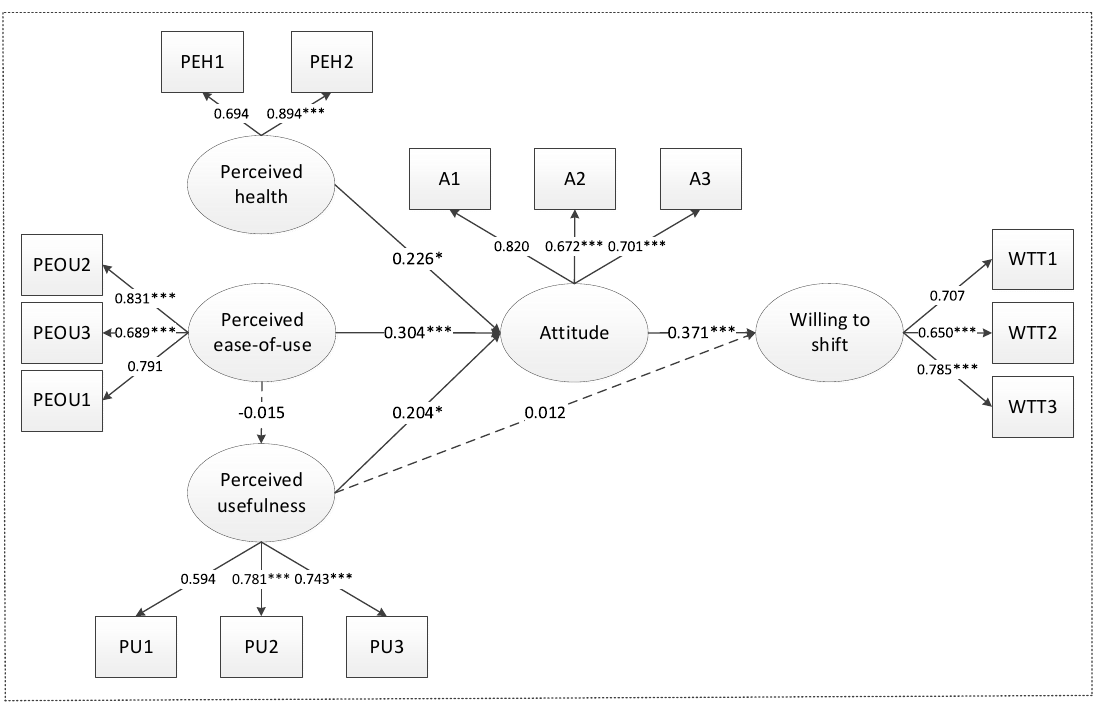
Figure 2. The results of the full model.